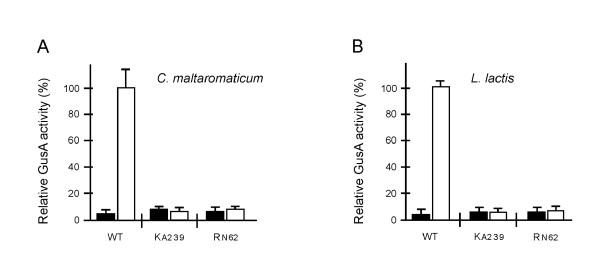
Functional analysis of the CS-CbnK-CbnR three-component regulatory system in a homologous (A) and heterologous (B) host. C. maltaromaticum LV17C and L. lactis MG1363 transformants carried pLQPBM1 and either pBRKR (WT columns), pBRKA239R (KA239 columns), or pBRKRN62 (RN62 columns). The transformants were treated with 20 μg/ml of CS (white columns) or 0.05% trifluoroacetic acid (black columns). GusA activity was determined as described in Methods. Means ± standard error of triplicate assays are shown.